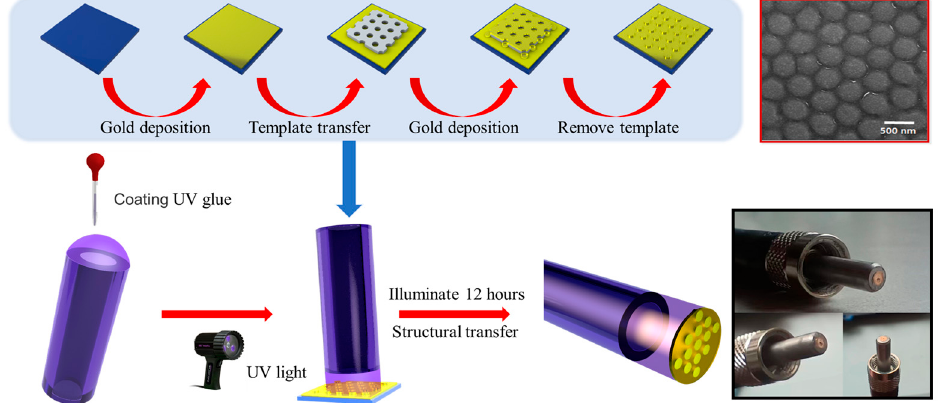
Figure 2. Schematic of the transferring preparation procedure for the designed plasmonic fiber probe by patterning nanodisk array/thin film structure. The entire fabrication procedure mainly consists of two processes: one is the designed nanostructure fabricated on the Si substrate by using an ultrathin porous AAO membrane (top panel); the other is the transferring of the designed nanostructure from the planar Si substrate to fiber end face using UV curing glue (bottom panel). The upper right inset shows an SEM image of the Au nanodisk array/thin film structure on the Si substrate. The bottom right inset shows photographs of the fabricated nanodisk array/thin film-based fiber probe.